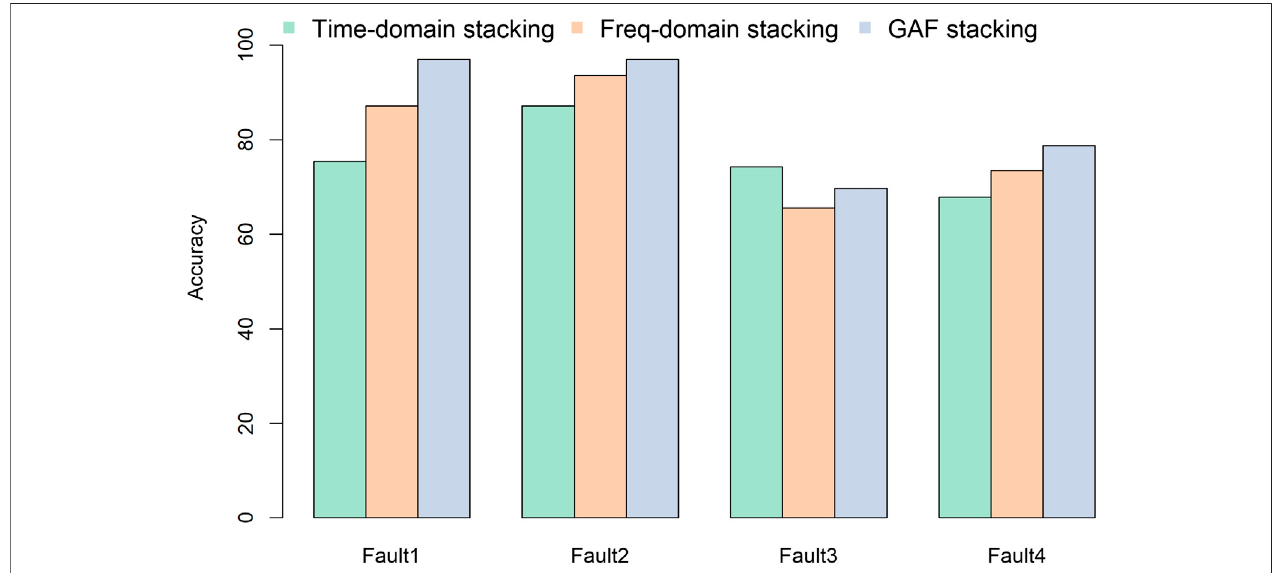
FIGURE 8 | Model accuracy results from different encoding